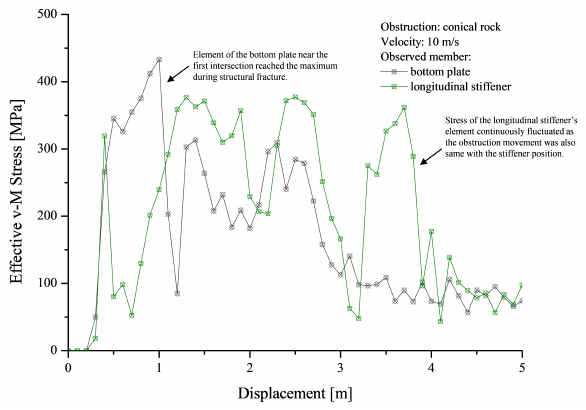
Figure 10: Failure stress (von Mises criterion) of longitudinal mem- bers in the ship grounding.